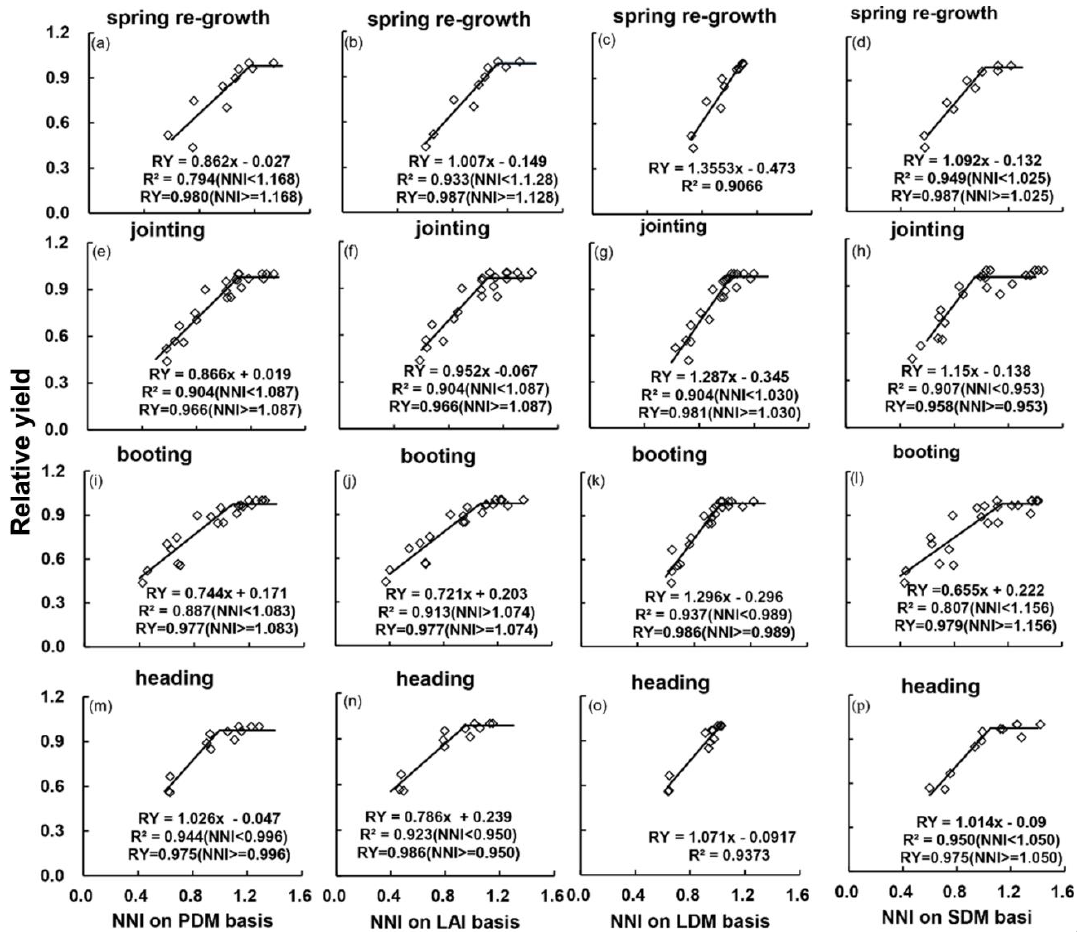
Figure 6. Relationships between relative yield (RY) and nitrogen nutrition index (NNI) on the bases of different critical N dilution curves at different growth stages (Dataset from experiments 4 and 5; ( a , e , i , m ): plant dry matter basis; ( b , f , j , n ): LAI basis; ( c , g , k , o ): leaf dry matter basis; ( d , h , l , p ): stem dry matter basis).